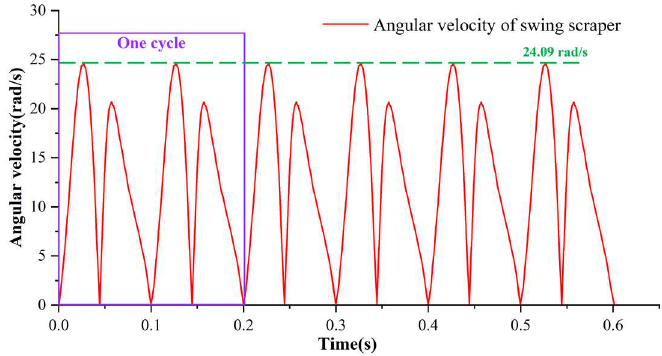
Figure 9. The curve of angular velocity of the swing scraper.